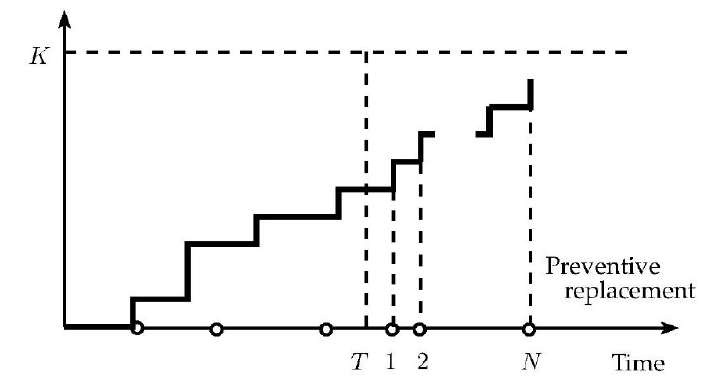
Fig. 1. Process for preventive replacement